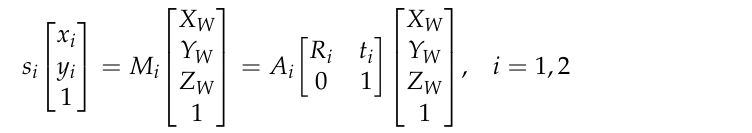
Figure 1. Experimental setup of the conventional stereo-DIC method. To implement the stereo-DIC measurement, the camera calibration is an essential step for determining the correspondence between the 3D space point and the two-dimensional (2D) image points. The basic principle of binocular stereo-vision [3,4] is presented in Figure 2. P ( X W , Y W , Z W ) is a 3D physical point on the measured surface, p 1 ( x 1 , y 1 ) and p 2 ( x 2 , y 2 ) represent its stereo projections in the images of left and right cameras. By triangulation, the 3D coordinates of the physical point P in the world coordinate frame can be recovered from the two image points p 1 and p 2 according to the following equation: